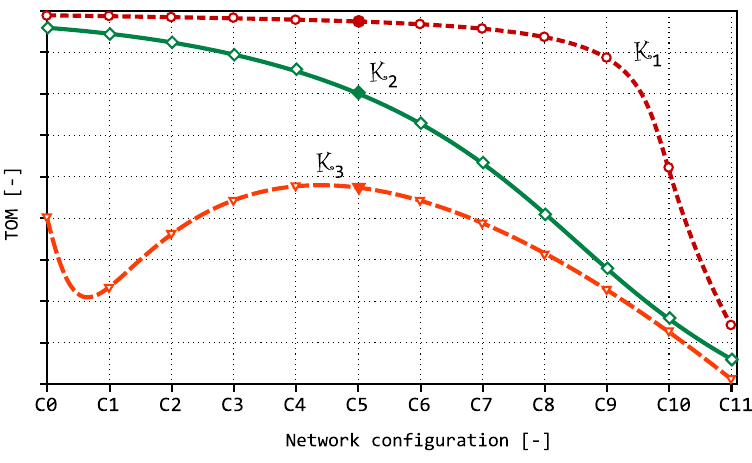
Figure 6. Optimization